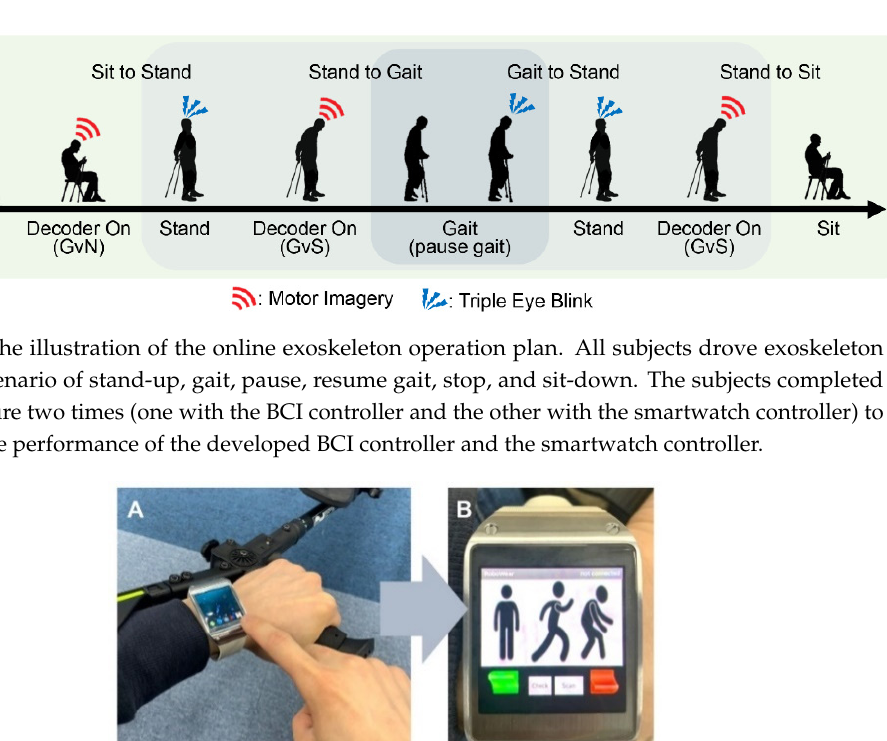
Figure 4. The illustration of the feedback buffer which represented the size of 10 of the exoskeleton BCI controller. ( A ) MI buffer is linked to the classifier_GvN (Gait MI vs. Do-nothing). ( B ) MI buffer is linked to the classifier_GvS (Gait MI vs. Sit MI).